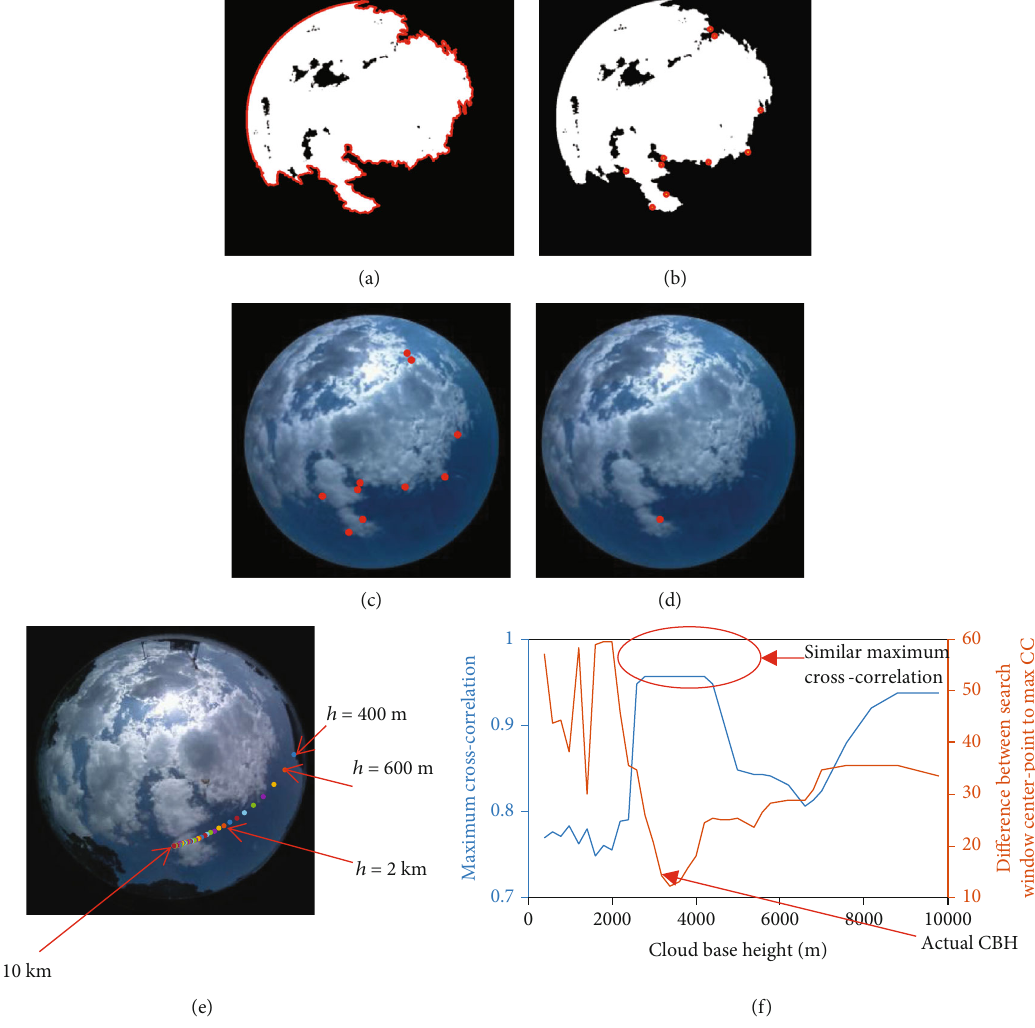
Figure 15: (a) Cloud boundary points extracted from “ bwboundaries ” function, (b) selected 10 points closer to the center, (c) selected boundary locations on the image captured from the camera placed at location 1, (d) a selected point ½ x , y (cid:2) , (e) mapped points for the selected point ½ x , y (cid:2) for di ff erent CBHs on the image taken from the camera placed at location 2, and (f) the maximum CC received for di ff erent CBHs (blue) and the pixel di ff erence between the center point of the search window to the maximum CC point for CBHs